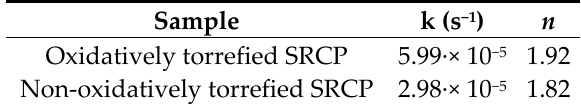
Table 1. Kinetic parameters of oxidative and non-oxidative torrefaction.